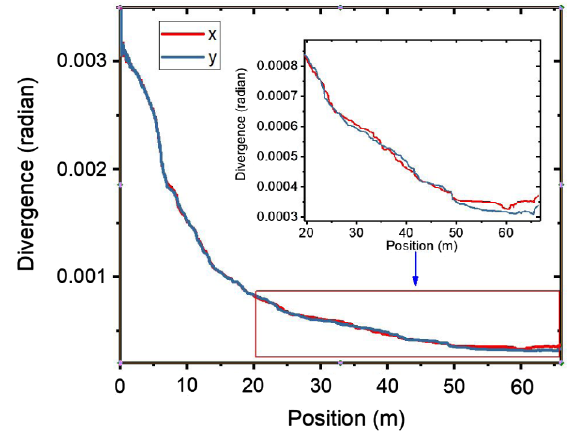
FIG. 39. Asymmetric divergence imparted to the beam by the rf field of the spoke cavity along the SC section of the MEHIPA